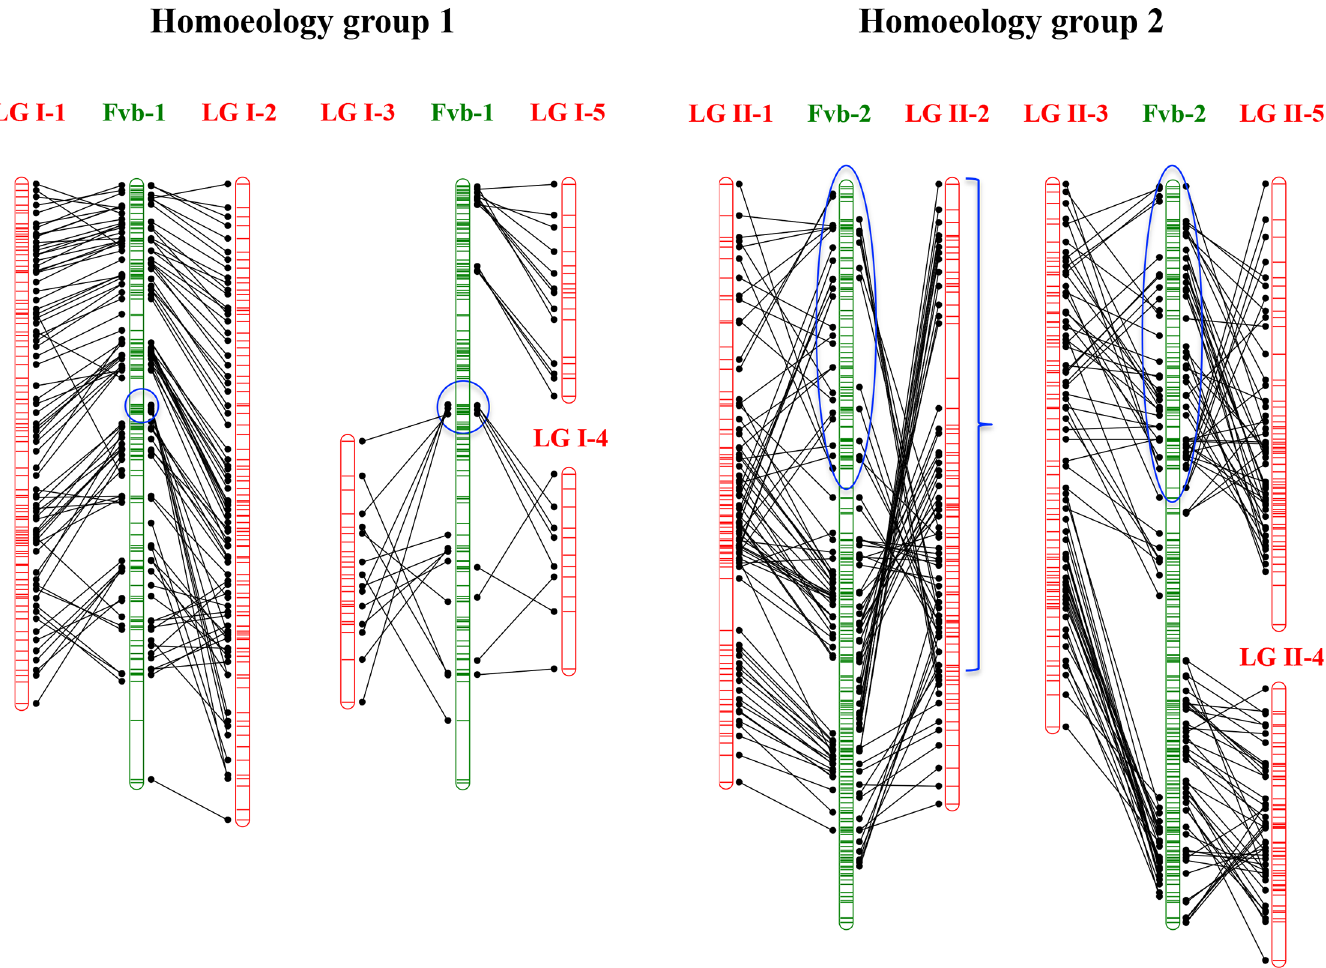
Fig 5. A comparison between diploid Fragaria vesca physical maps of chromosomes 1 and 2 (in green) and their LG homoeologues on the ‘ 232 ’ × ‘ 1392 ’ octoploid linkage map (in red). Marker order in F . vesca is based in the genome assembly of Tennessen et al., 2014. Rearrangements are highlighted in